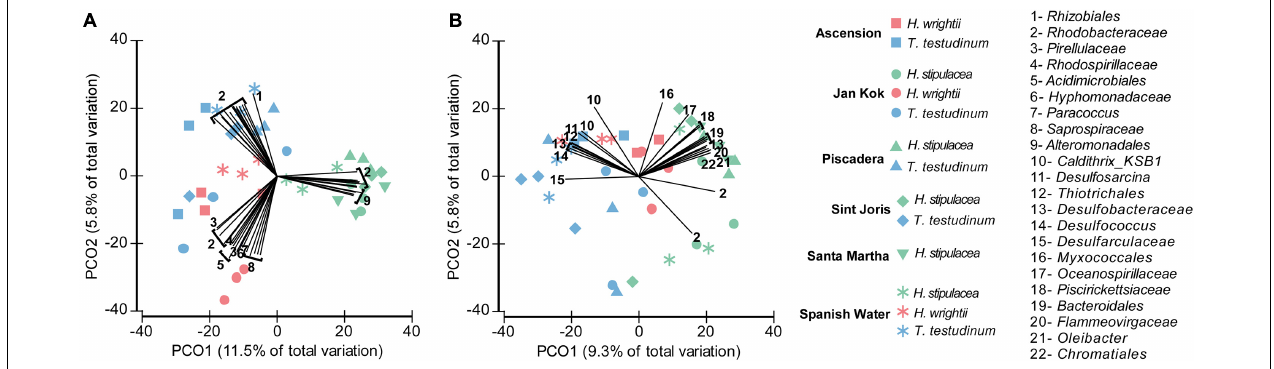
FIGURE 4 | Principal coordinate analysis (PCO) plot (based on Bray–Curtis dissimilarity matrix of square root transformed bacterial abundances) showing canonical axes that best discriminate the bacterial community assemblages of leaves (A) and roots (B) across the three seagrass species ( H. stipulacea —green, H. wrightii —red, and T. testudinum —blue) and locations (Ascension—square, Jan Kok—circle, Piscadera—triangle, Sint Joris—diamond, Santa Marta—inverted triangle, and Spanish Water—asterisk). Displayed vectors show the bacterial groups with a Pearson correlation larger than 0.6. Colors were changed so the different species’ colors would match with the other figures.